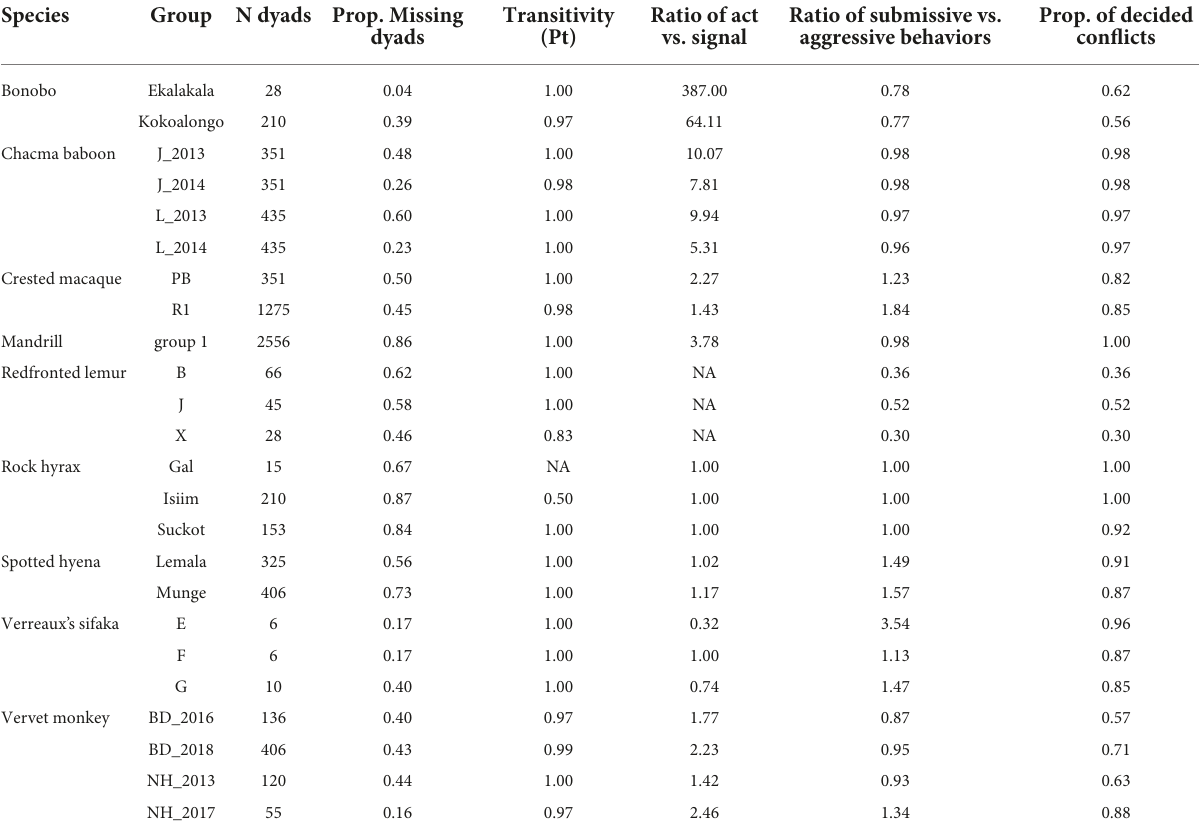
TABLE 2 Characteristics of the intersexual hierarchies and conflict types used in this study. Species Group N dyads Prop. Missing